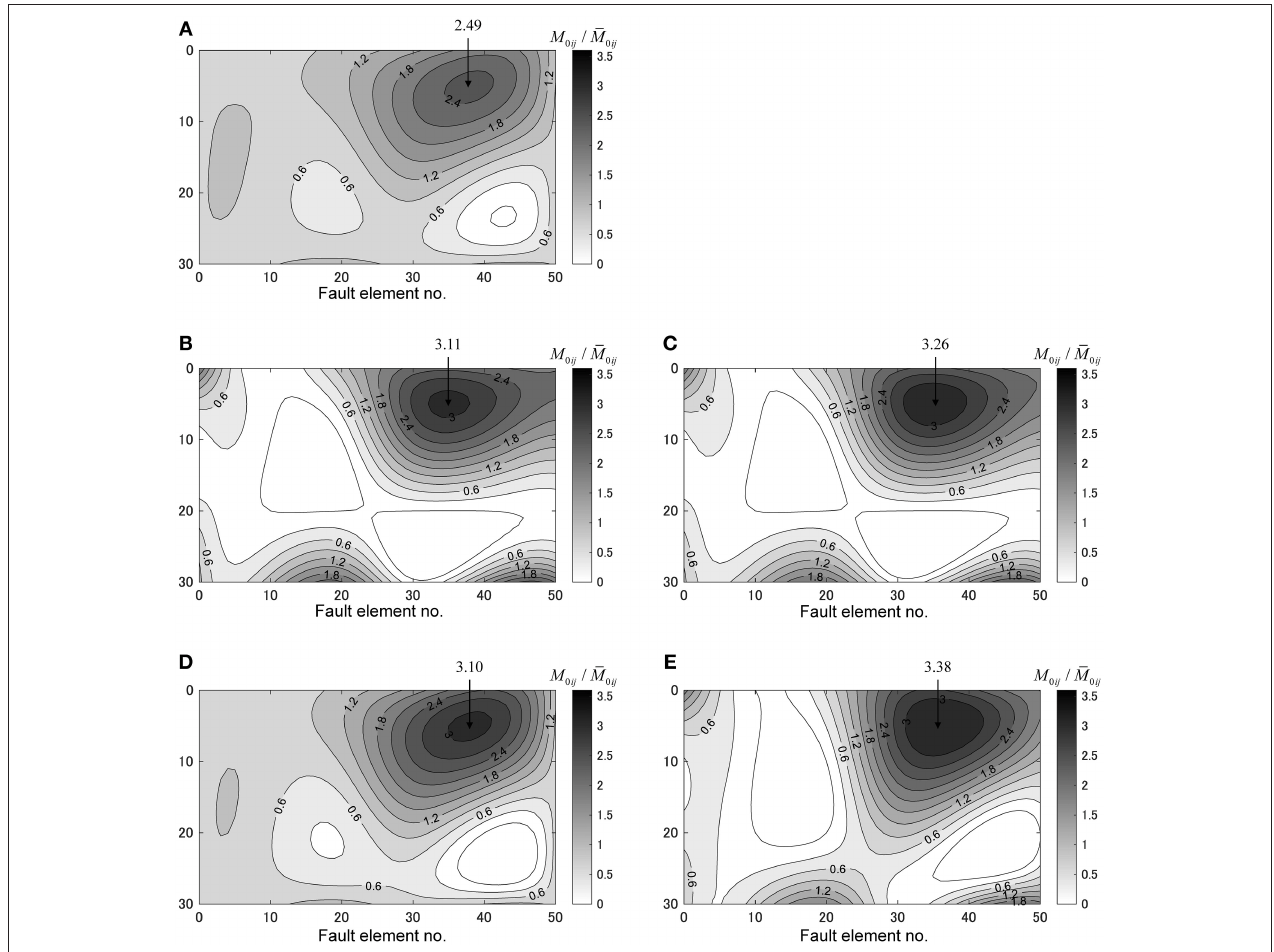
FIGURE 10 | Distribution of seismic moment ratio at each uncertainty level α . (A) α